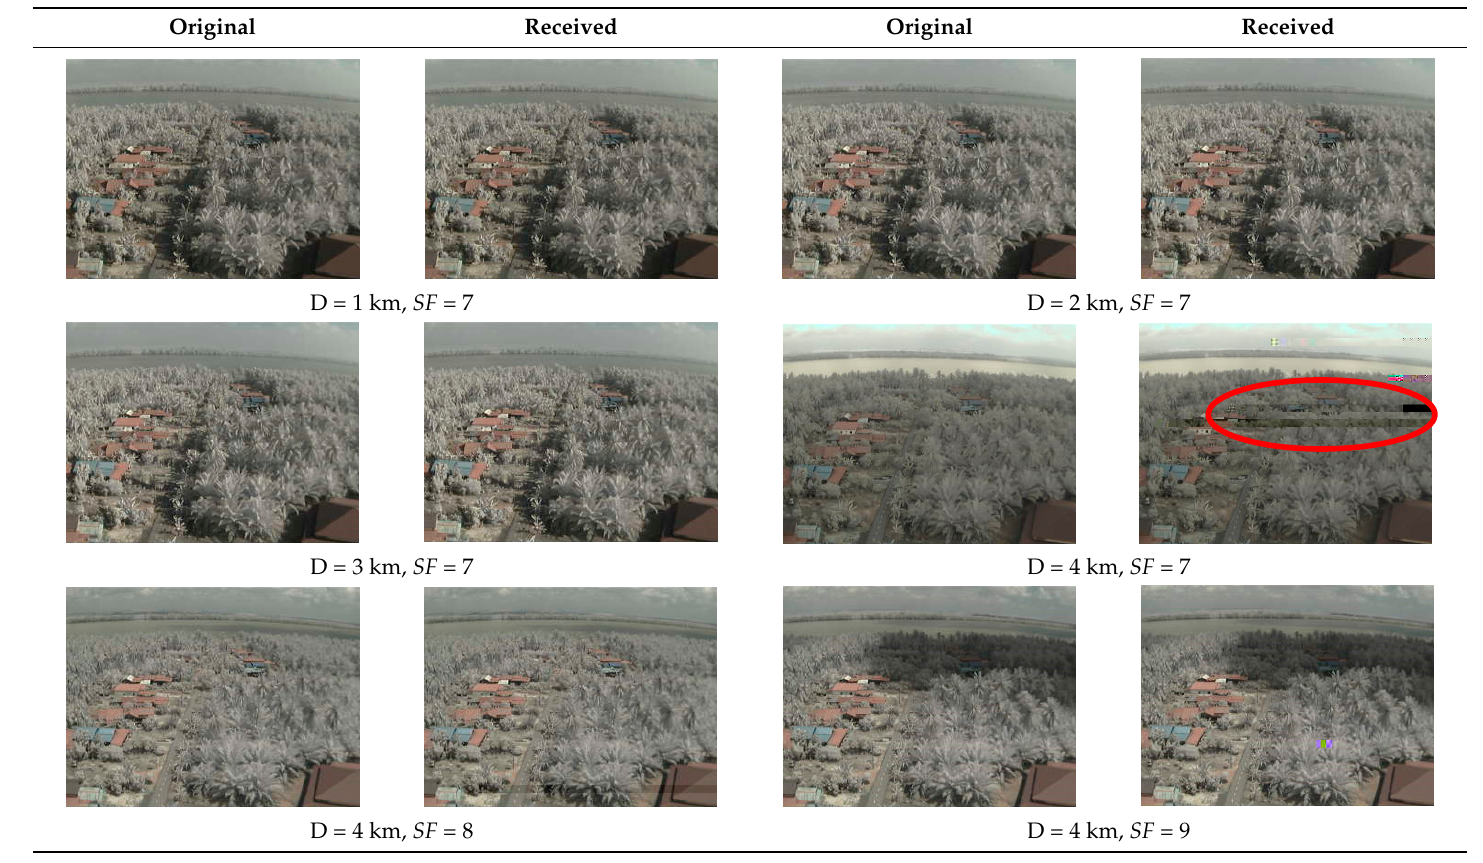
Table 5. Visual comparison between original and transferred images for each SF setting used in testing.